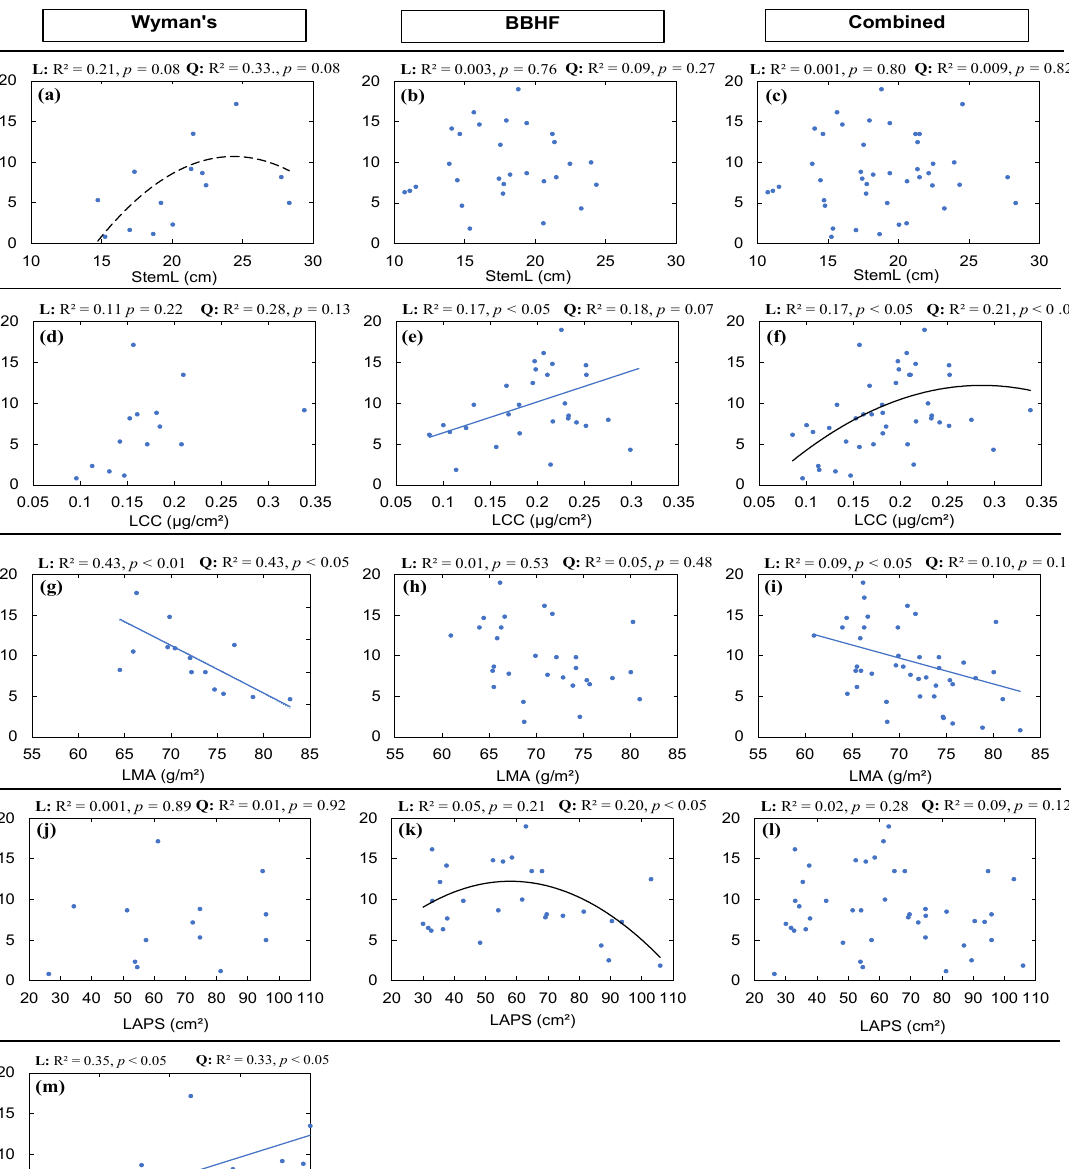
significant linear (Figure 5m: R 2 = 0.35, p < 0.05) and quadratic relationships (Figure 5m: R 2 = 0.33, p < 0.05) between soil temperature (SoilT) and NBS; however, we found a higher coefficient of determination (R 2 ) associated with the linear relationship.